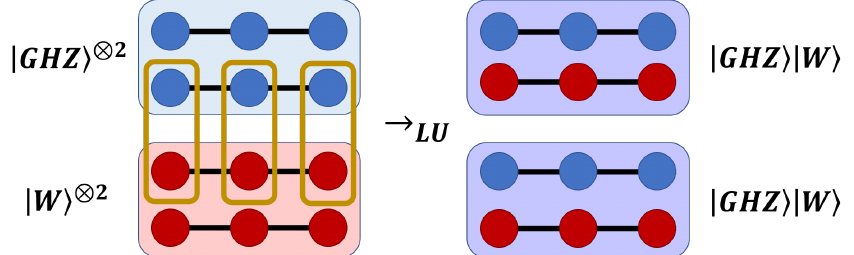
Figure 2: Example of a multi-state transformation changing the SLOCC class of the initial states using LU operations. The initial states both consist of a tensor product of two states. By applying LUs (indicated by beige boxes), one can SWAP one of the GHZ states with one of the W states, yielding two copies of a new state that is in a different SLOCC class to both initial